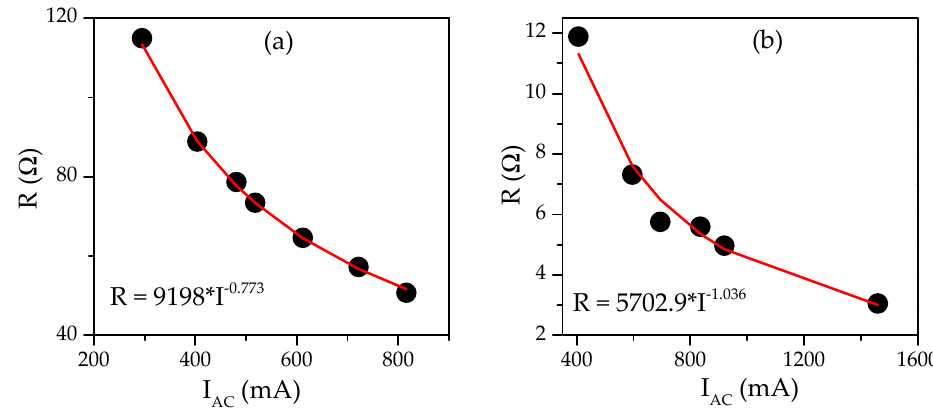
Figure 7. Equivalent resistance of ( a ) external coil and ( b ) internal coil. Solid lines represent the approximation. The approximation coe ffi cient ( R 2 ) is more than 0.99.